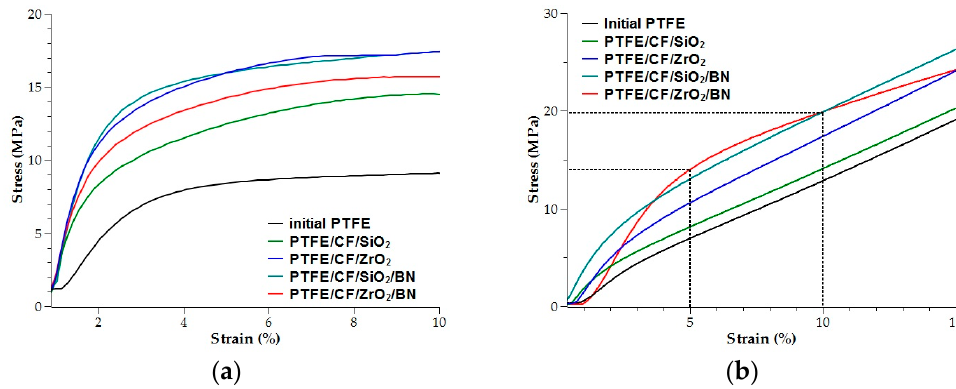
Figure 2. Representative stress-strain curves of PTFE and PCM: ( a ) tensile testing; ( b ) compressive testing.